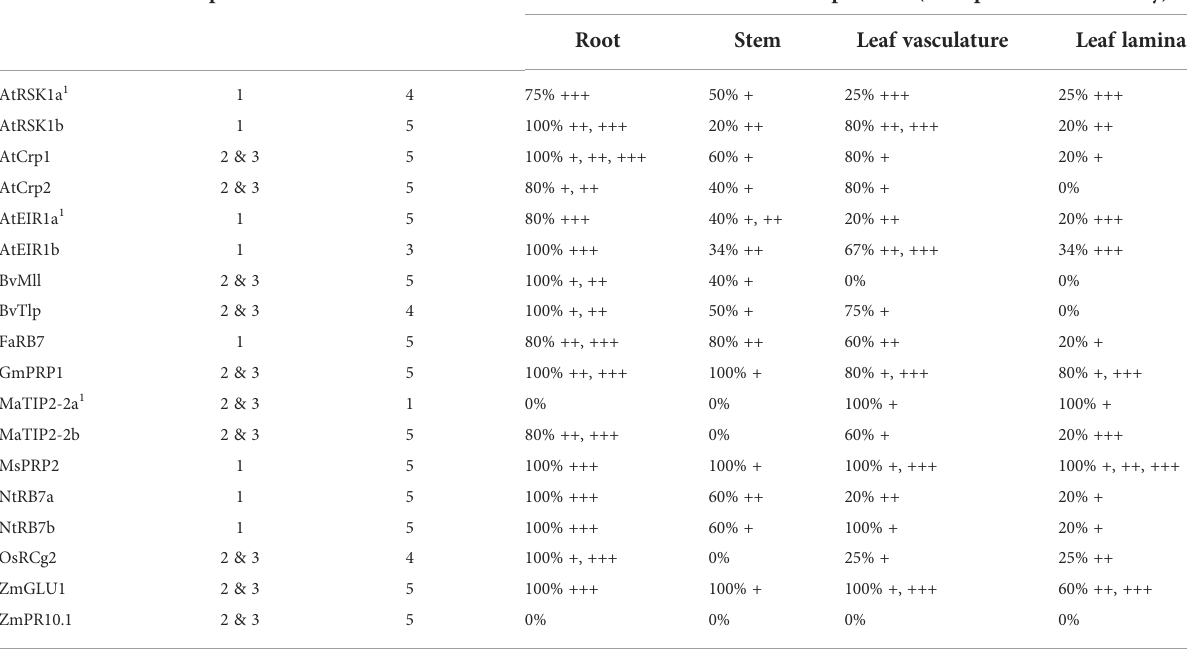
TABLE 2 Summary of histochemical GUS staining results for all transgenic tobacco